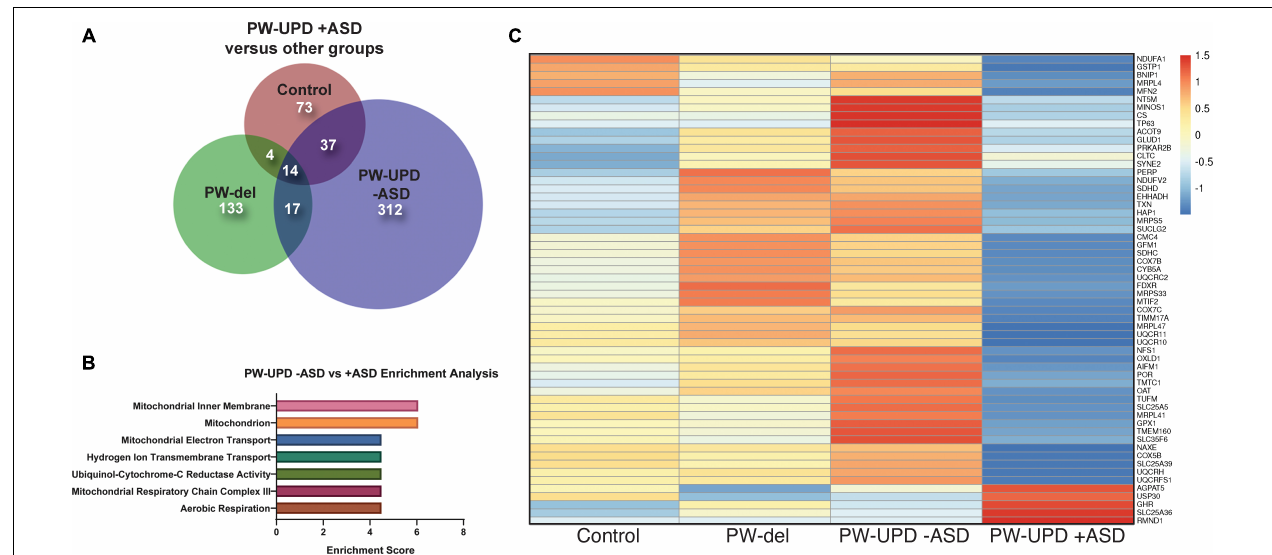
FIGURE 4 | RNAseq analysis reveals enrichment in differentially expressed mitochondrial transcripts in the PW-UPD + ASD group. (A) Venn diagram using all the significantly differentially expressed transcripts (p-value ≤ 0.05, FDR ≤ 0.05) versus PW-UPD + ASD for each PWS subtype and control created using BioVenn (Hulsen et al., 2008). (B) The list of differentially expressed transcripts PW-UPD -ASD versus UPD + ASD (p-value ≤ 0.05, FDR ≤ 0.05) was used as input for DAVID (Huang da et al., 2009a,b) enrichment analysis. The top enrichments (enrichment score ≥ 3.0) were transcripts located within mitochondria and having mitochondrial functions (p-value ≤ 0.002). (C) Heatmap of transcripts identified by DAVID analysis as mitochondrial related. Expression of genes identified as driving the mitochondria enrichment in the PW-UPD + ASD group were used to create this heatmap across all subgroups (Metsalu and Vilo, 2015). Colors indicate read counts from high (red) to low (blue). Most of the mitochondrial transcripts identified in DAVID enrichment set have reduced expression in the PW-UPD + ASD group compared to all other